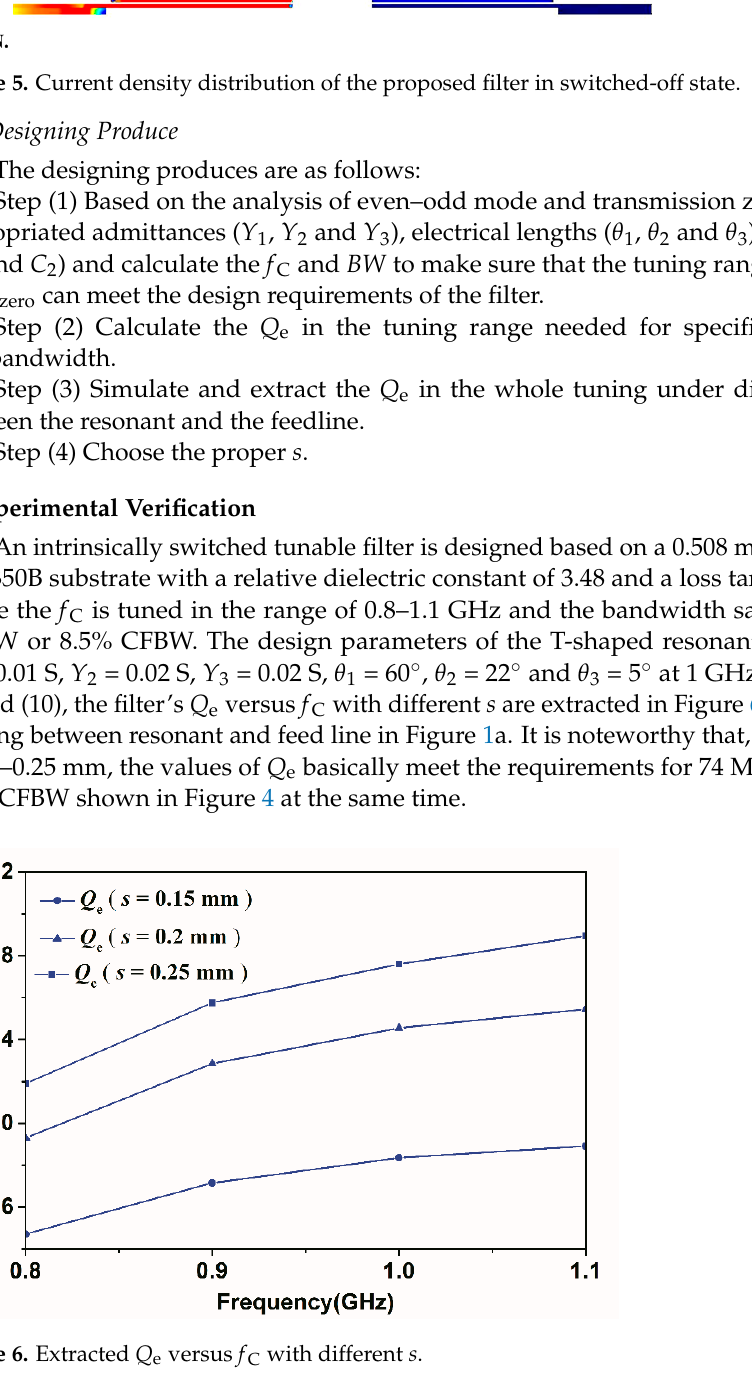
– Figure 7. The photograph of the proposed filter. The simulated and measured frequency responses of the proposed prototype with three reconfigurable states are shown in Figure 8. Figure 8a,b depicts the tuning of the center frequency from 0.8–1.1 GHz with 74 MHz CABW and 8.5% CFBW, respectively. It also can be seen that a transmission zero on the upper band edge increases as the center frequency increases in both Figure 8a,b. The measured 3 dB bandwidth of the CABW filter and 3 dB fractional bandwidth of the CFBW filter are 74 ± 1 MHz and 8.5 ± 0.1%,